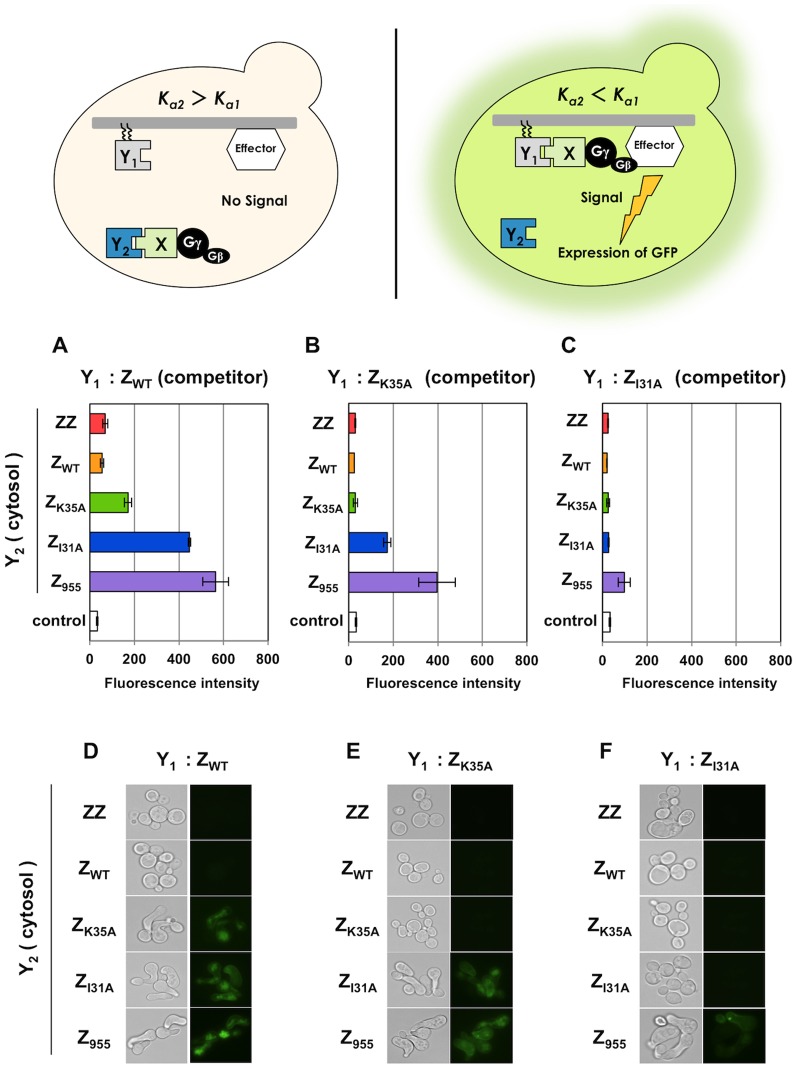

GFP transcription assays to test the selection of affinity-attenuated proteins.(A–C) Flow cytometry analyses. Fluorescence intensities of the engineered strains expressing membrane-anchored ZWT (A), ZK35A (B) and ZI31A (C) as the parental ‘Y1’ proteins. White bars indicate control yeast strain lacking expression of ‘Y1’ and ‘Y2’ (transformed with pGK415 mock vector to BFG2118). (D–F) Fluorescence microscope observations. Fluorescence micrographs of the engineered strains expressing membrane-anchored ZWT (D), ZK35A (E) and ZI31A (F) as the parental ‘Y2’ proteins. Five Z variants (ZZ, ZWT, ZK35A, ZI31A and Z955) were expressed as the cytosolic ‘Y2’ candidate proteins in each strain. To investigate transmission of the signal, 5 µM of α-factor was used for each strain. Standard errors of three independent experiments are shown.